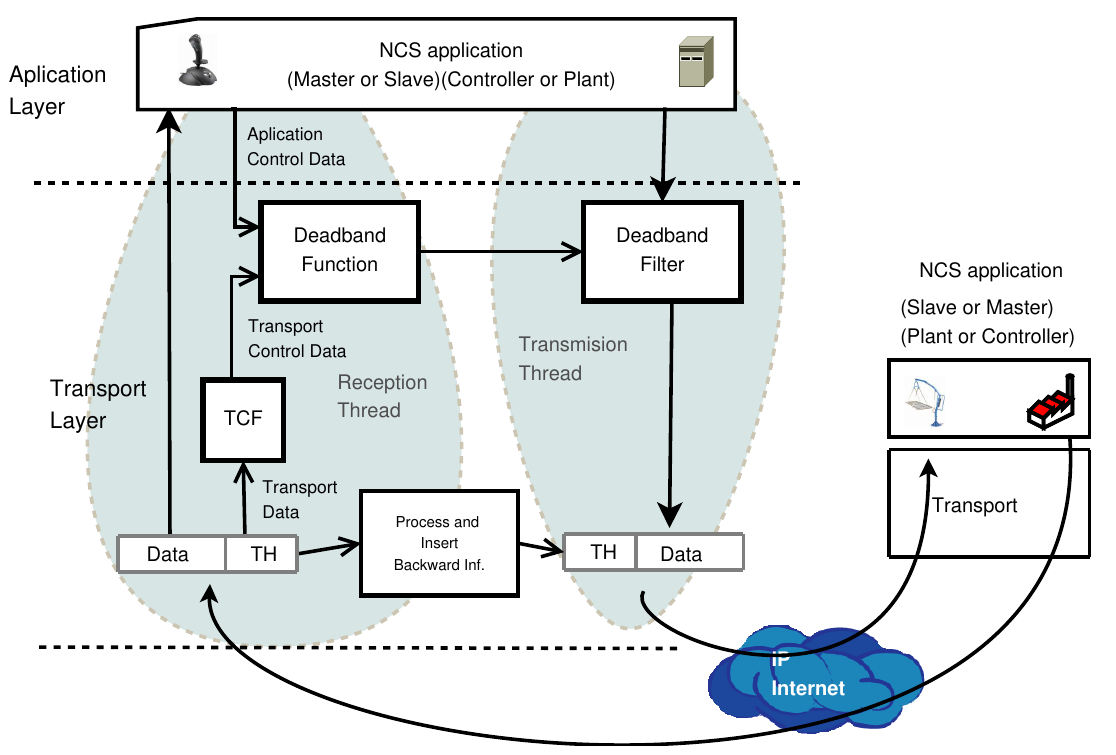
Figure 3. Network Adaptive Deadband general